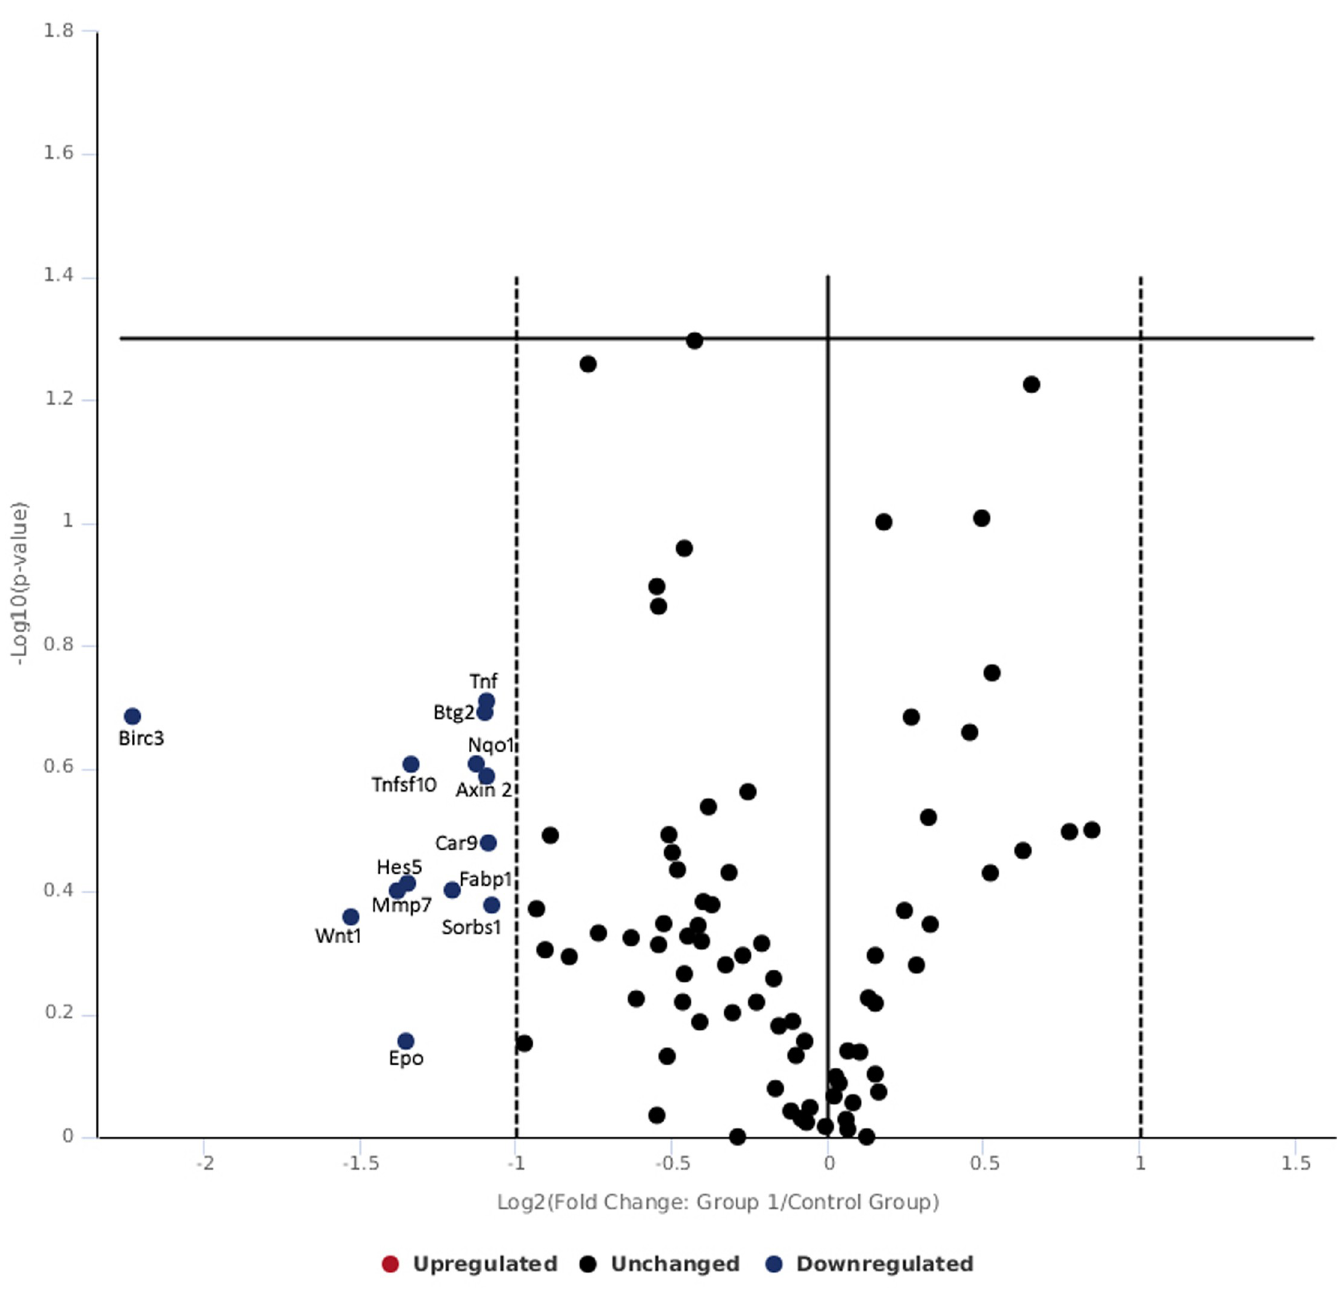
Fig 3. Volcano plot of genes expressed following 532 nm laser exposure at low irradiance of 0.10 W/cm 2 .